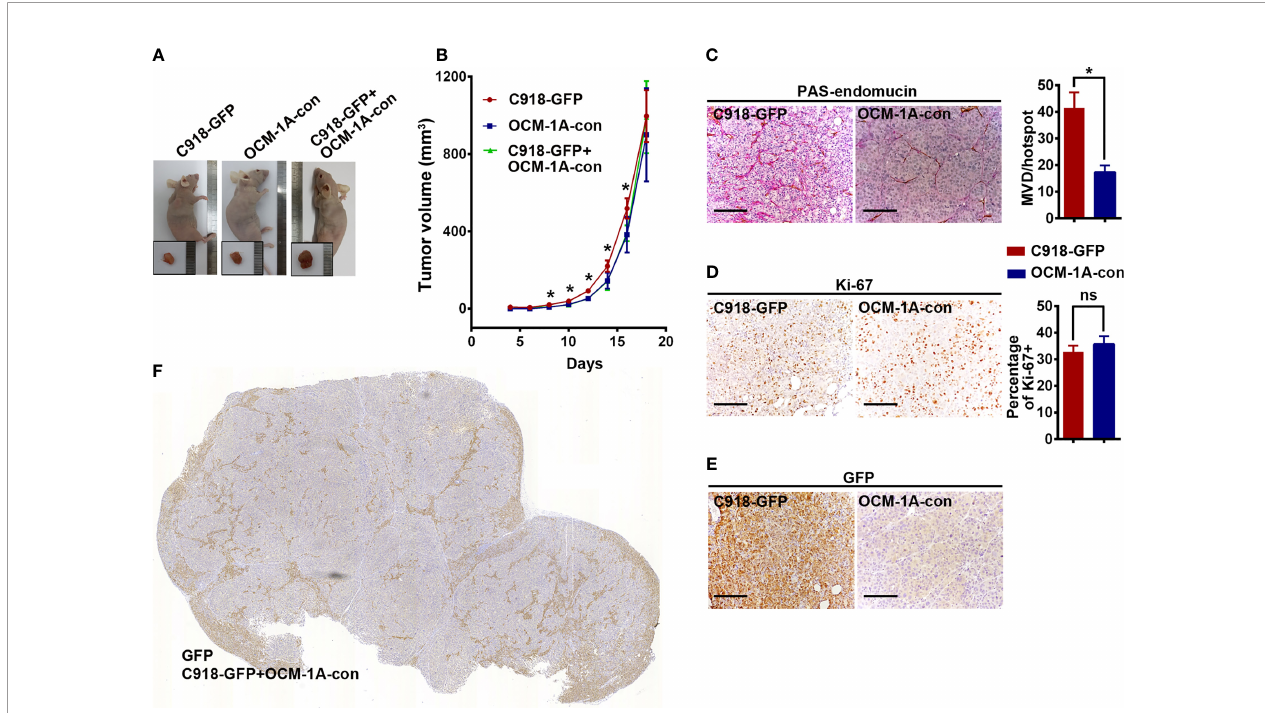
FIGURE 2 | No difference in tumorigenesis derived from xenografts alone or coxenografts. (A) Representative mice and corresponding tumors 18 days after subcutaneous injection of C918-GFP, OCM-1A-con and C918-GFP + OCM-1A-con cells * P < 0.05. (B) The statistics of tumor volume at different times after subcutaneous injection are shown (n = 6). (C – E) Representative images, stained for PAS-endomucin to identify blood vessels ( P < 0.0001), Ki-67 to evaluate cell proliferation ( P = 0.12) and GFP to verify lentiviral infection ef fi ciency in xenografts of C918-GFP and OCM-1A-con cells. Scale bar 100 m m. (F) Optical scans stained for GFP in coxenograft tissue sections (C918-GFP+OCM-1A-con) showing the distribution of C918-GFP cells. Scale bar 1 mm; ns, not signi fi